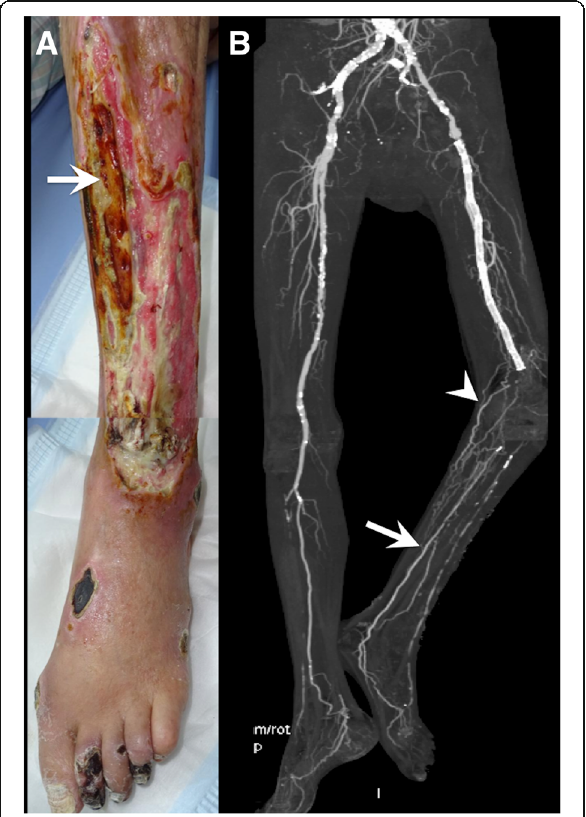
Fig. 1 a Preoperative photograph showing the severe tissue defect at the lower leg in the form of an exposed tibia (arrow), multiple ulcers, and necrosis of the foot, including the toe, dorsum, lateral malleolus, and heel. b Preoperative computed tomography showed multiple arterial lesions, a patent posterior tibial artery (arrow), and well-developed sural artery